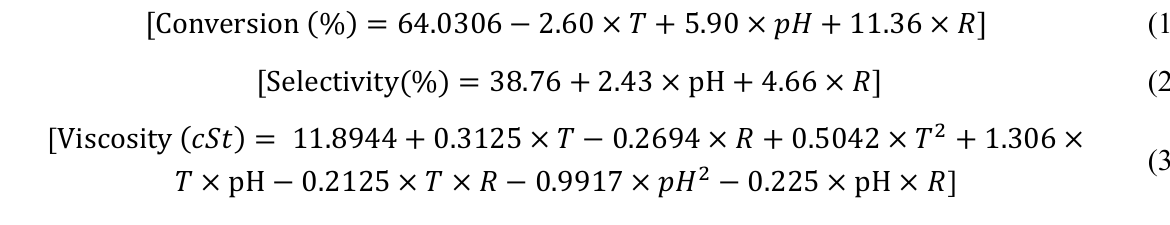
Table 5. Analysis of variance (ANOVA) for Cinematic